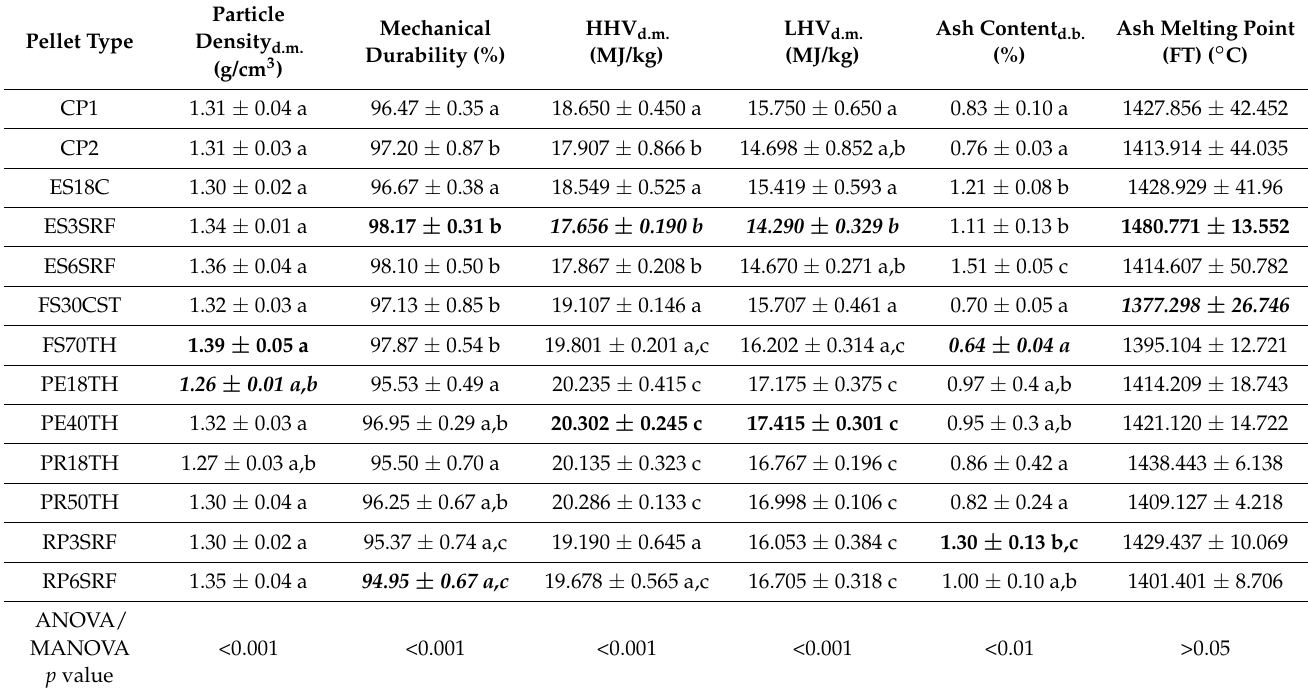
Table 4. Average ± standard deviation for some physical and physico-chemical parameters of various pellet types (most of the parameters show statistically significant differences). Upper values are highlighted in Bold, while lower values are in Bold-Italic. Different letters show statistically significant differences between groups (at a significance level of 5%) following Tukey’s test for physical parameters. (d.m.: dry matter; d.b.: dry